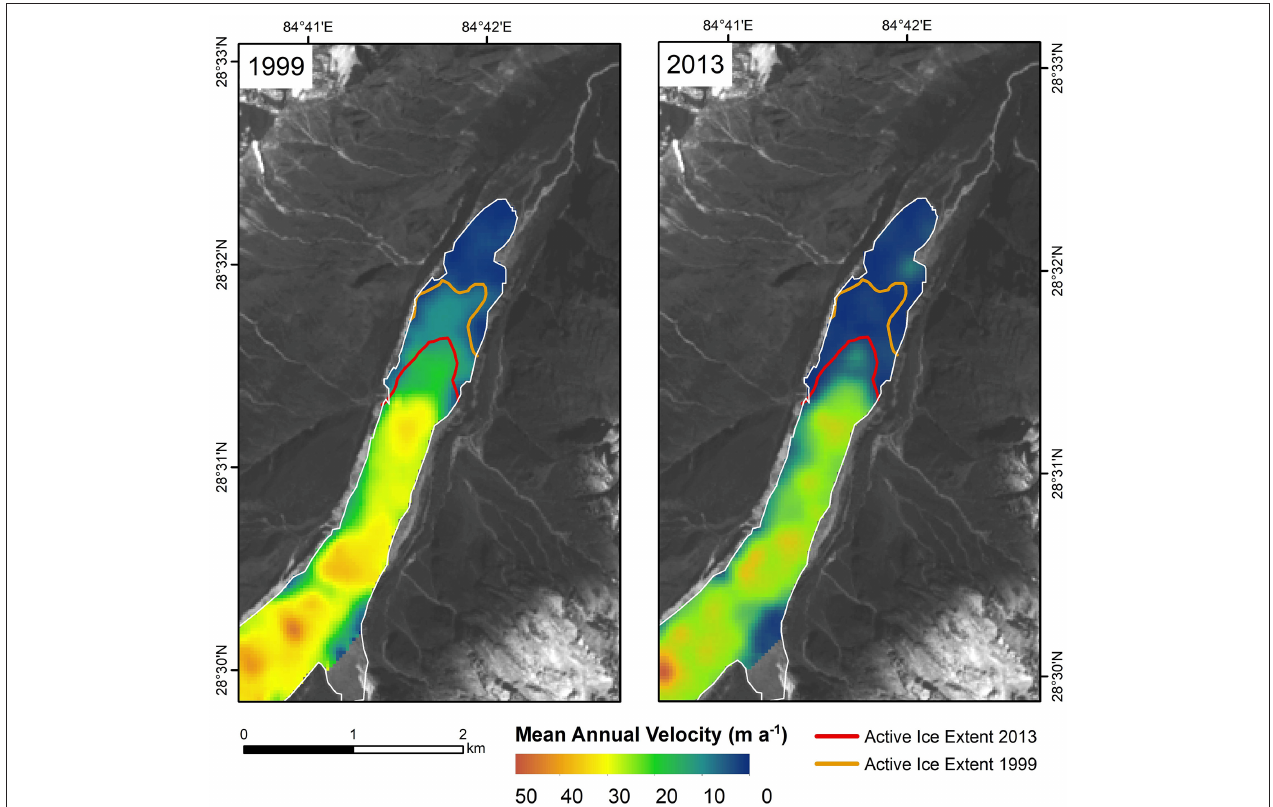
FIGURE 10 | A comparison of ice velocities at Hinang Glacier (G084689E28511N) between 1999/2000 and 2013/2014. Despite no detectable changes in the extent of terminus (shown in a white dashed line), the terminus velocities have decreased. Background: Landsat 8 (26th December